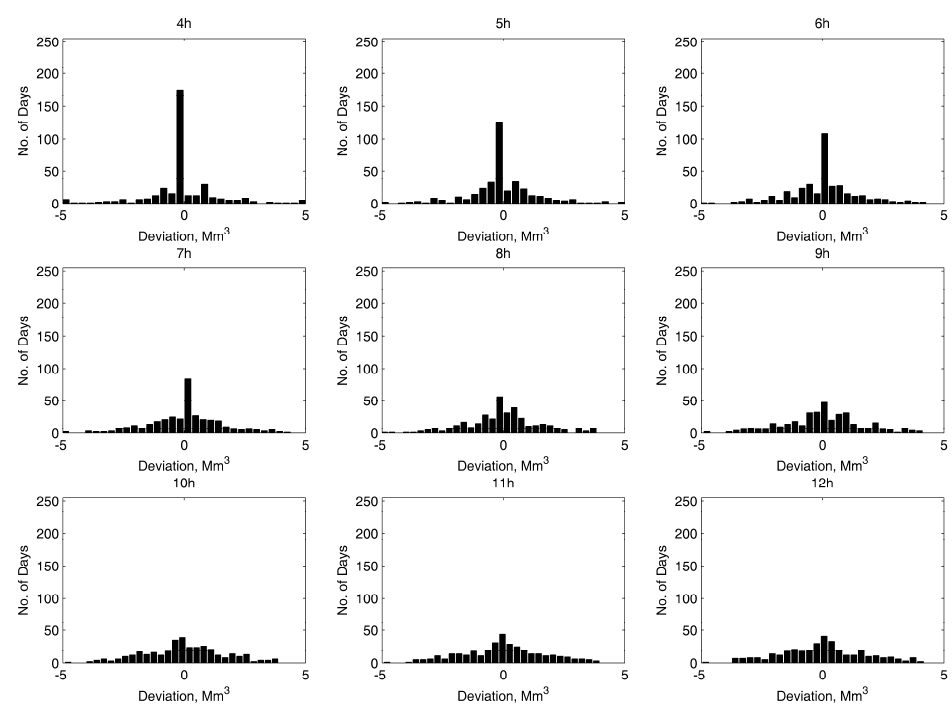
Figure 15. Histogram of the deviations with respect to the daily-cycle operation, of each PSHP participating in the DM and the SRS.